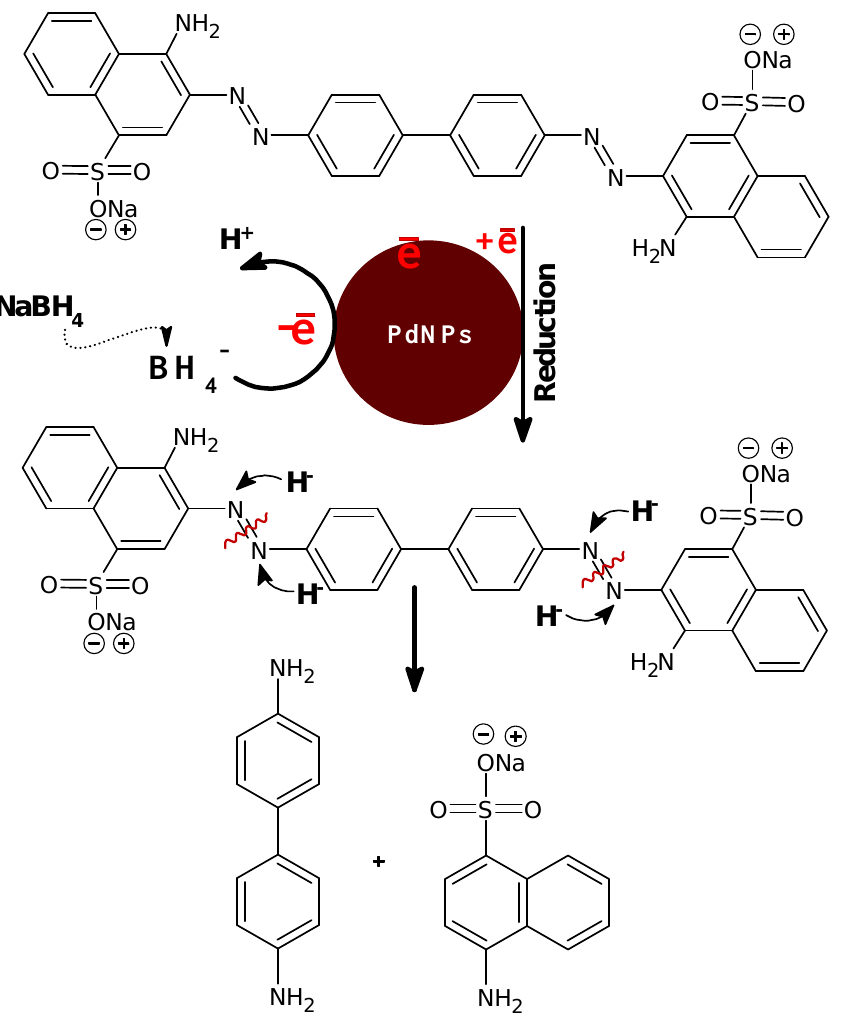
Figure 12. A plausible mechanism for the CR dye degradation by NaBH 4 using PdNPs as a catalyst.